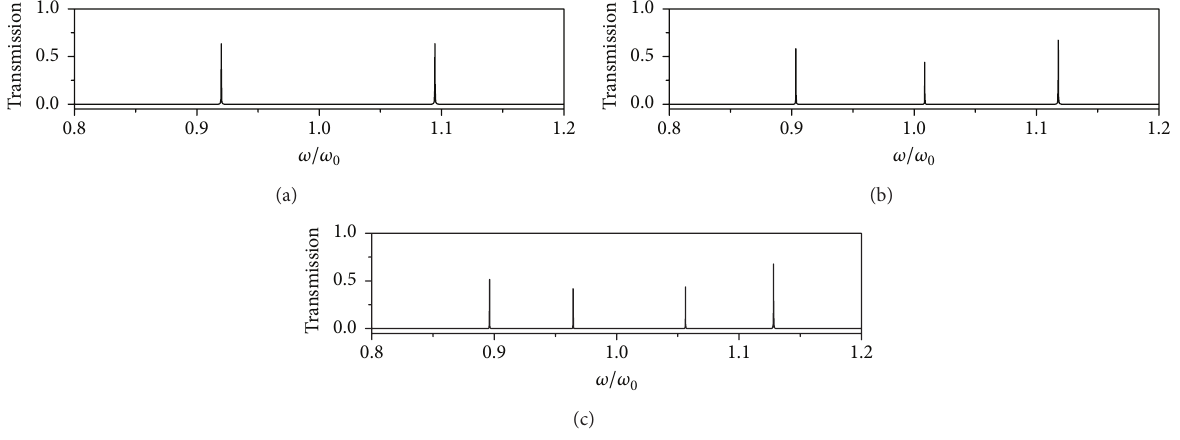
Figures 5, 6, and 7, (a), (b), and (c) are corresponding to 𝑛 = 1, 𝑛 = 2, and 𝑛 = 3 for the QW structure (𝐵𝐴) 6 (𝐵𝐵𝐴𝐵𝐵) 𝑛 (𝐴𝐵) 6